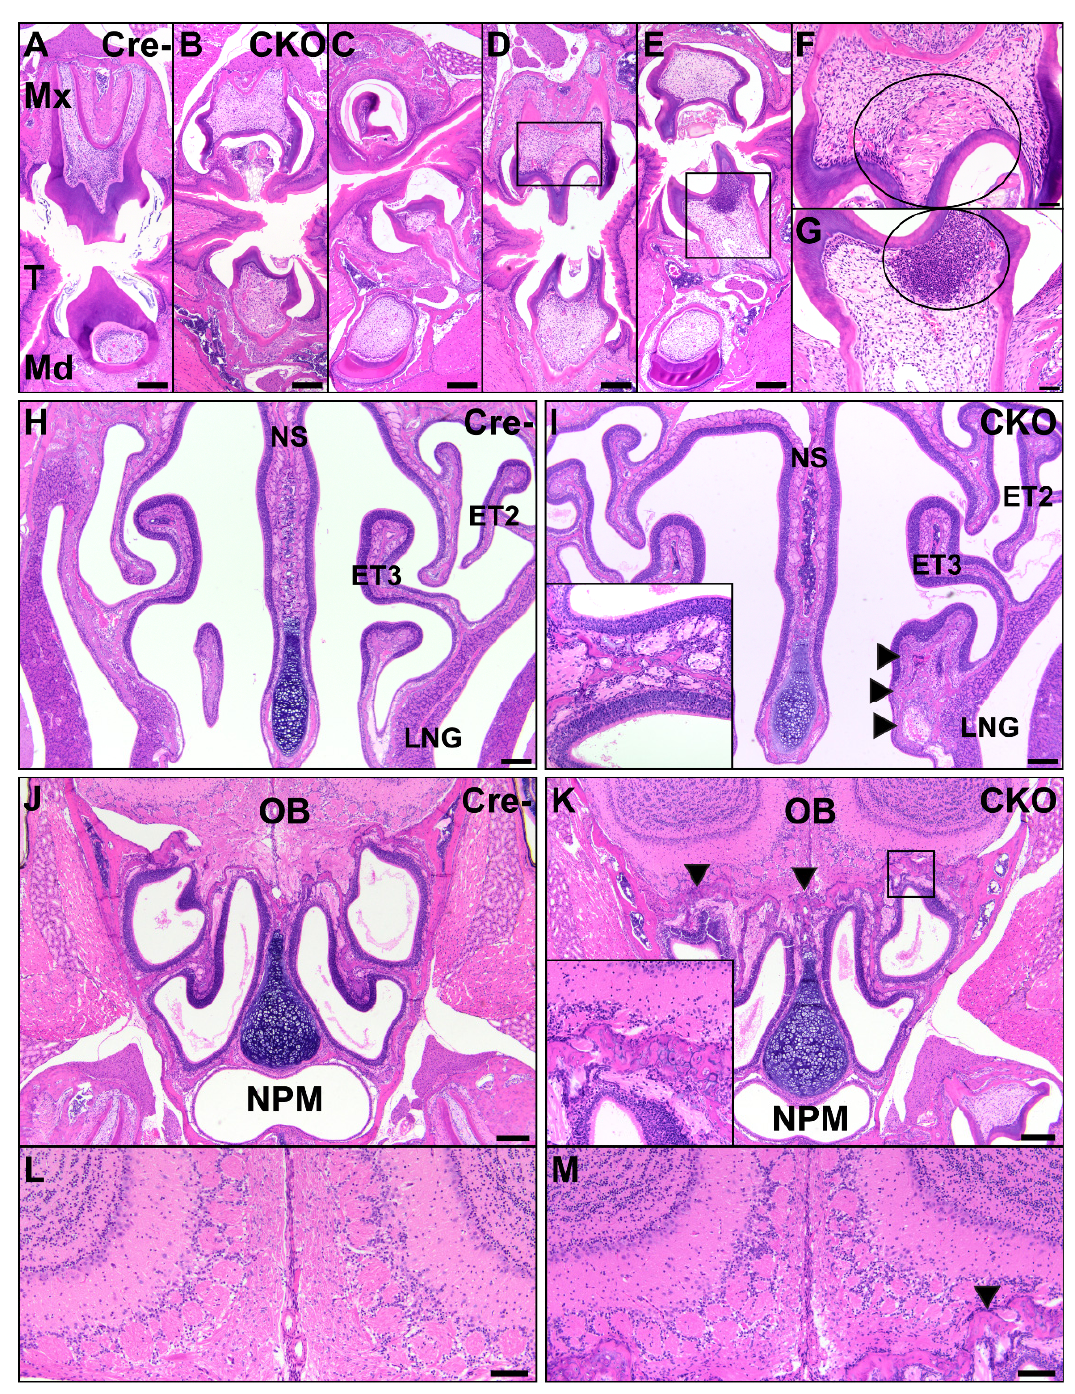
Figure 7. Abnormal facial structures in CKO mice. The CKO mice ( B – G ) had numerous abnormalities of tooth development in the maxillary and mandibular teeth, particularly in molars, compared to Cre- control mice ( A ). These included delayed eruption ( B , C ), short tooth roots ( B – E ), underdevelopment of the tooth ( C ), and necrosis of odontoblasts and the pulp cavity with infiltration of neutrophils ( D , E ). A higher magnification of the pulp cavities shows necrosis with clefting (( F ), circle) and a marked neutrophilic response to necrosis (( G ), circle). Scale bars ( A – E ) = 200 µm. Scale bars ( F – G ) = 50 µm. T: tongue; Mx: maxillary; Md: mandibular. In the nasal cavity, the CKO mice ( I ) had consistent osteochondral dysplasia of the nasal turbinates, with variations in the affected bones and involvement of the nasal septum, compared to Cre- control mice ( H ). The inset shows the presence of neutrophilic inflammation lining a nasal turbinate from a different CKO mouse. Neutrophils extended to the cribriform in CKO mice but were not present in Cre- controls. The arrows delineate a dysmorphic, enlarged ethmoid turbinate. Scale bars = 200 µm. NS: nasal septum; ET2: ethmoid turbinate 2;